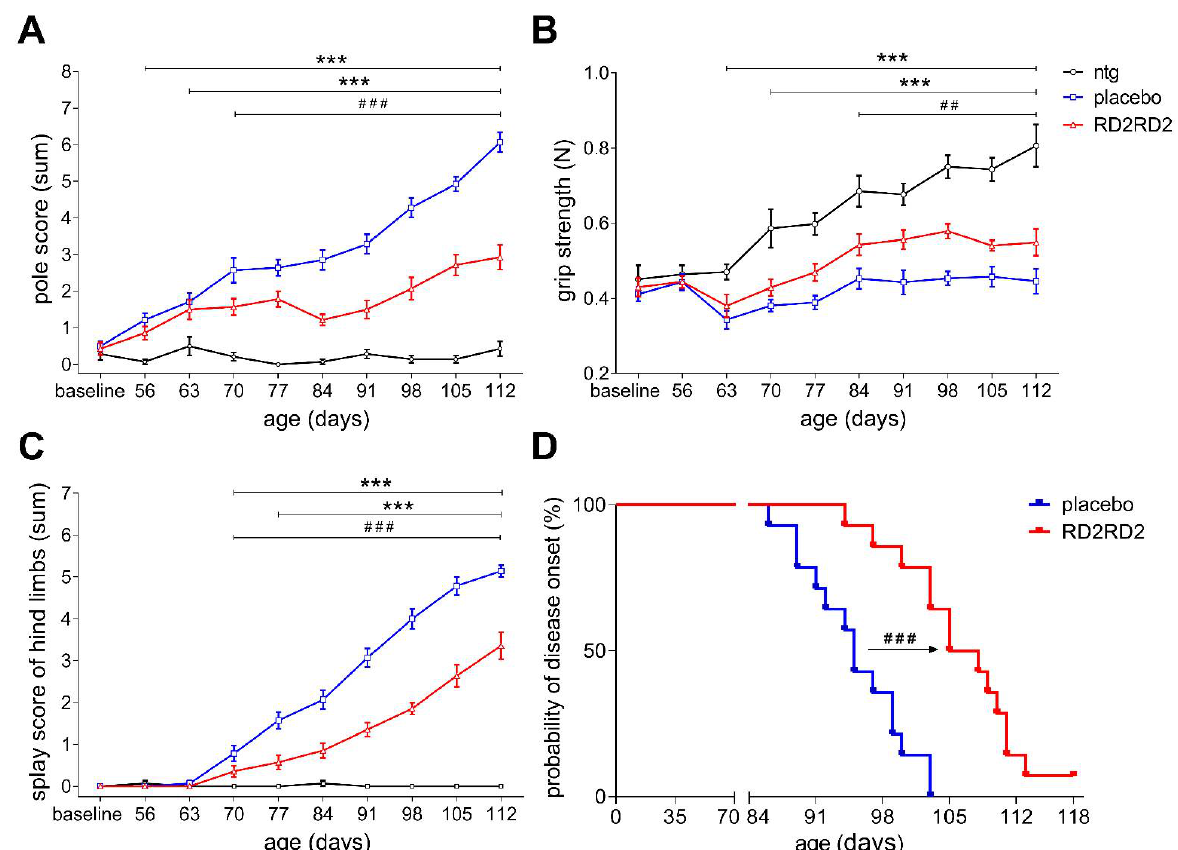
Figure 2. RD2RD2 administration prevented deficits in motor performance and delayed onset of disease in SOD1 G93A mice. Motor skills from RD2RD2-treated mice vs. placebo treatment were analysed using different motor tests, i.e., the pole test ( A ). In grip strength and splay reflex test of hind limbs ( B , C ) retardation of the motor impairments were measured. Disease onset was assessed using the score of Mead et al. (2011) [45] ( D ). Data is represented as mean ± SEM. Statistical calculations were conducted by two-way RM ANOVA with Fisher’s LSD post hoc analysis, n = 14 each group ( A – C ) or by Kaplan– Meier survival analysis with log-rank analysis ( D ), placebo = 14 and RD2RD2 n = 13. Results of analysis: ( A ) pole test, F(2,351) = 287.81, p < 0.001, ntg vs. placebo p < 0.002, ntg vs. RD2RD2 p < 0.012 and F(1,234) = 99.20, p < 0.001, Fisher LSD post hoc analysis, placebo vs. RD2RD2 p < 0.001; ( B ) grip strength test, F(2,351) = 54.13, p < 0.001, ntg vs. placebo p < 0.022, ntg vs. RD2RD2 p < 0.002 and F(1,234) = 29.31, p < 0.001, Fisher LSD post hoc analysis, placebo vs. RD2RD2 p < 0.001 and F(1,234) = 79.78, p < 0.001, Fisher LSD post hoc analysis, placebo vs. RD2RD2 p < 0.001 and ( D ) probability of disease onset